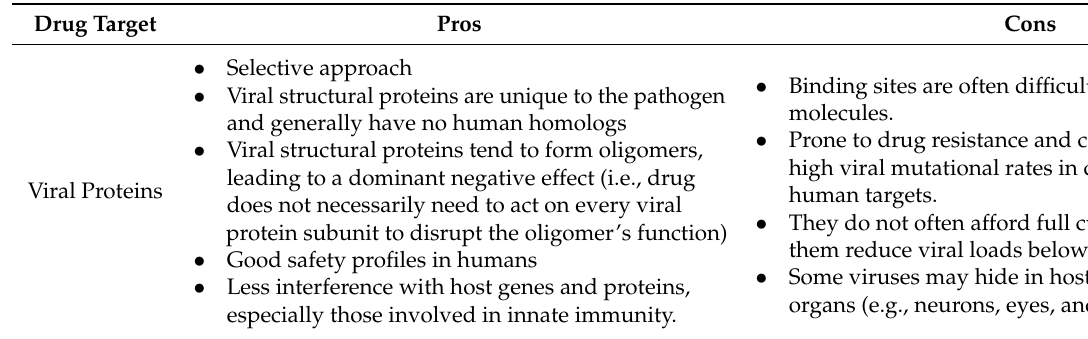
Table 5. The pros and cons of targeting viral proteins or host